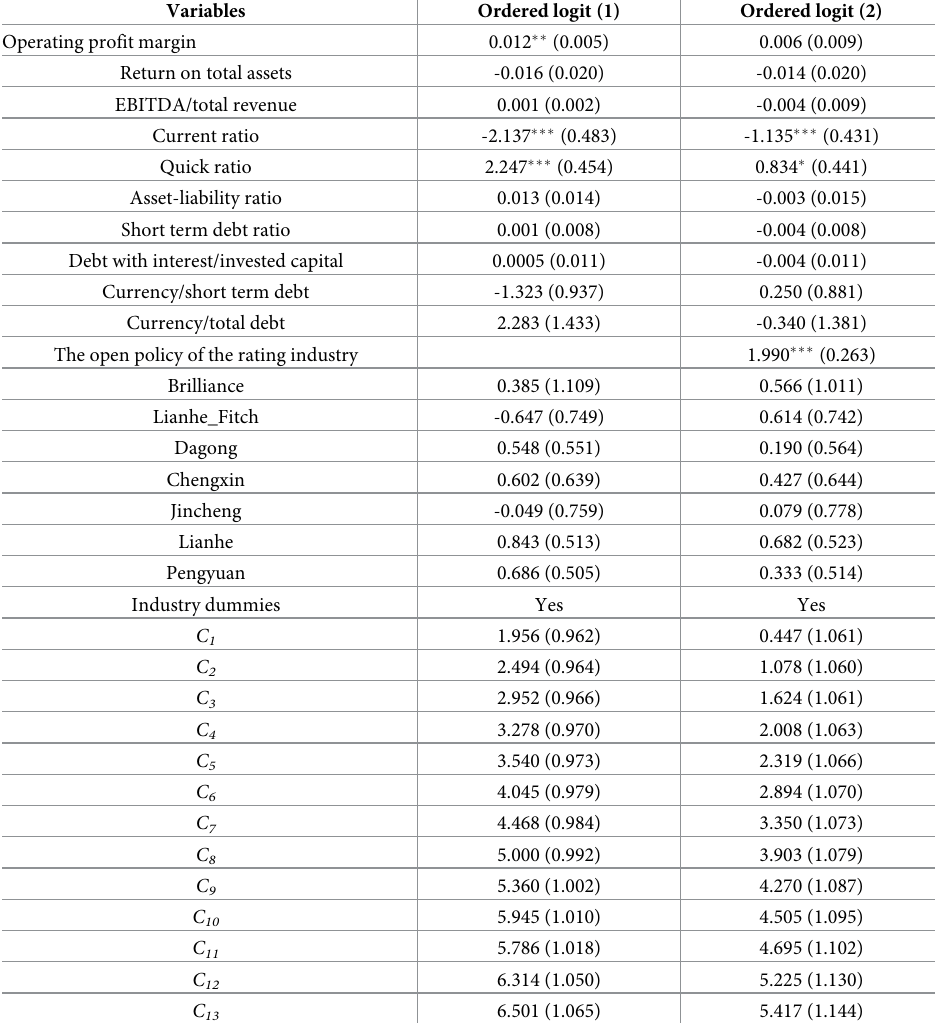
Table 8. Regression results of rating